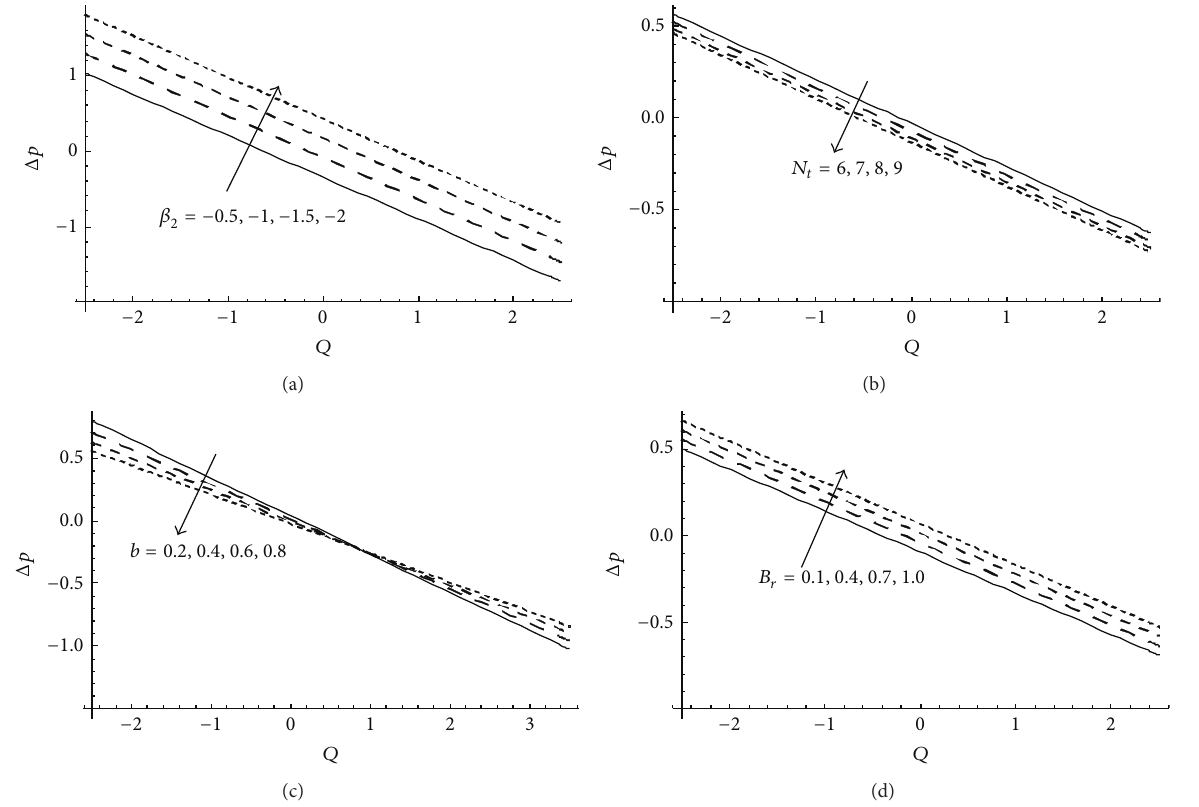
Figure 10: Variation of the pressure rise versus flow rate at 𝑎 = 0.3 , 𝑑 = 1 , and 𝛾 = 𝛾 1 = 0.5 for (a) 𝑏 = 0.5 , 𝑁 𝑏 = 0.8 , 𝑁 𝑡 = 0.5 , 𝐵 𝑟 = 0.5 , = 0.2 , 𝜙 = 0.2 , and 𝛽 𝐺 𝑟 = 0.2 , 𝜙 = 0.5 , 𝛽 𝐺 𝑟